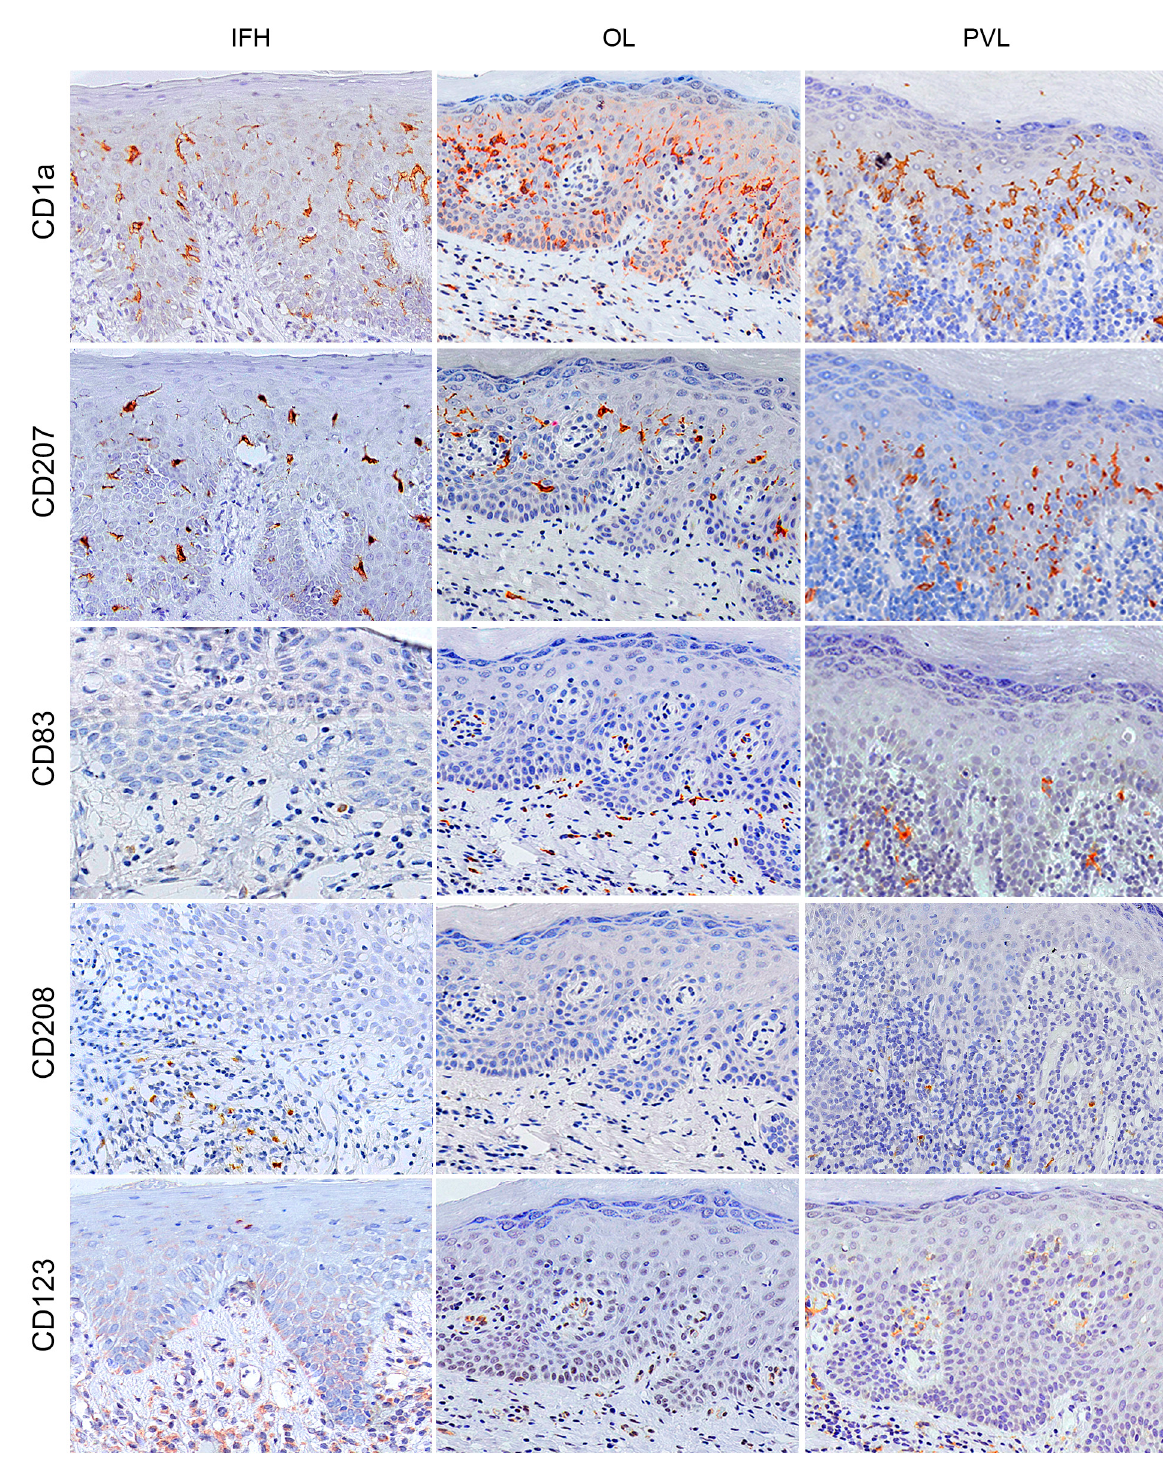
Figure 2. Representative image of the immunological staining pattern for different DC markers by the immunohistochemical technique. The columns show the study groups, the first column being the control group (IHF), the second column the OL group and the third column the PVL group. The lines show the markers that characterized DC for different groups, including CD1a, CD207, CD83, CD208 and CD123. Positive cells are represented by brown staining, and counterstained was performed using Carazzi’s hematoxylin. Original magnification: ×200 for all images. DC = dendritic cells; IHF = inflammatory fibrous hyperplasia; OL = oral leukoplakia; PVL = proliferative verrucous leukoplakia.